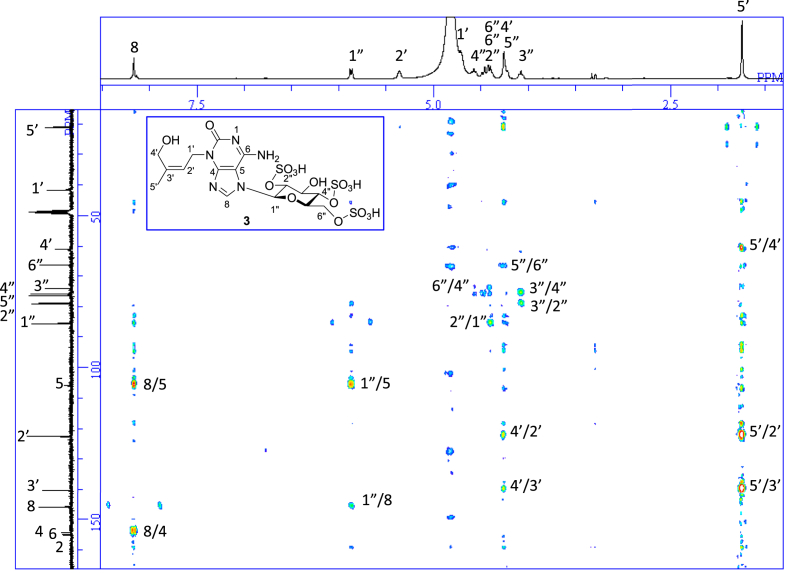
1H–13C HMBC of 3.